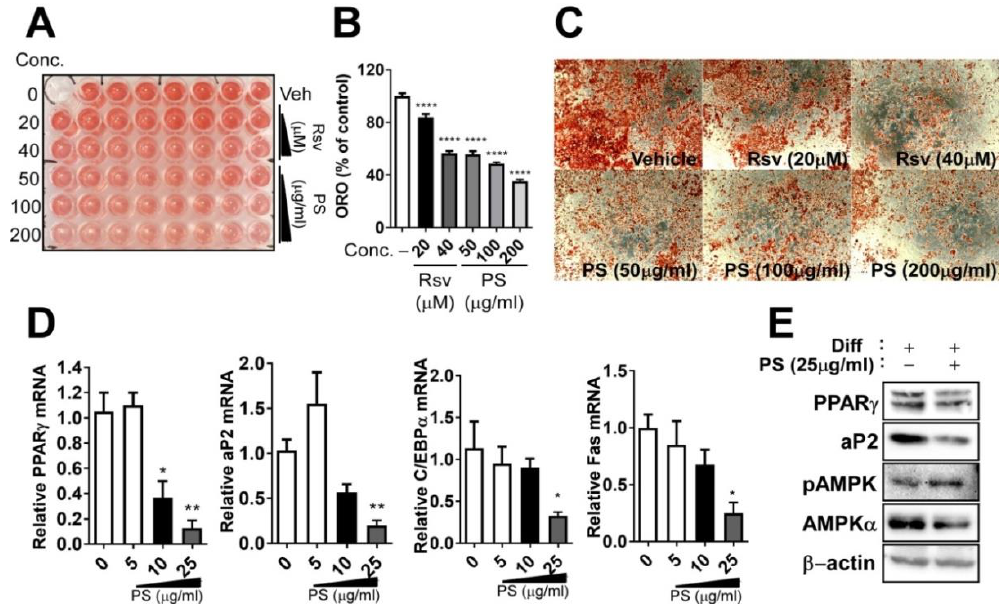
Figure 2. PSE inhibits adipogenesis in 3T3-L1 adipocytes. 3T3-L1 cells were seeded and induced to